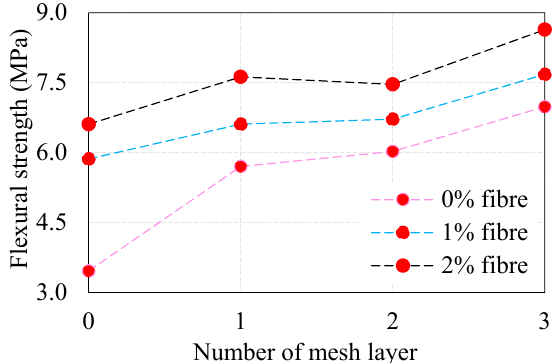
ff ect of fiber and EWM on flexural strength of ferrocement Figure 7. Combined effect of fiber and EWM on flexural strength of ferrocement panel. Figure 7. Combined e